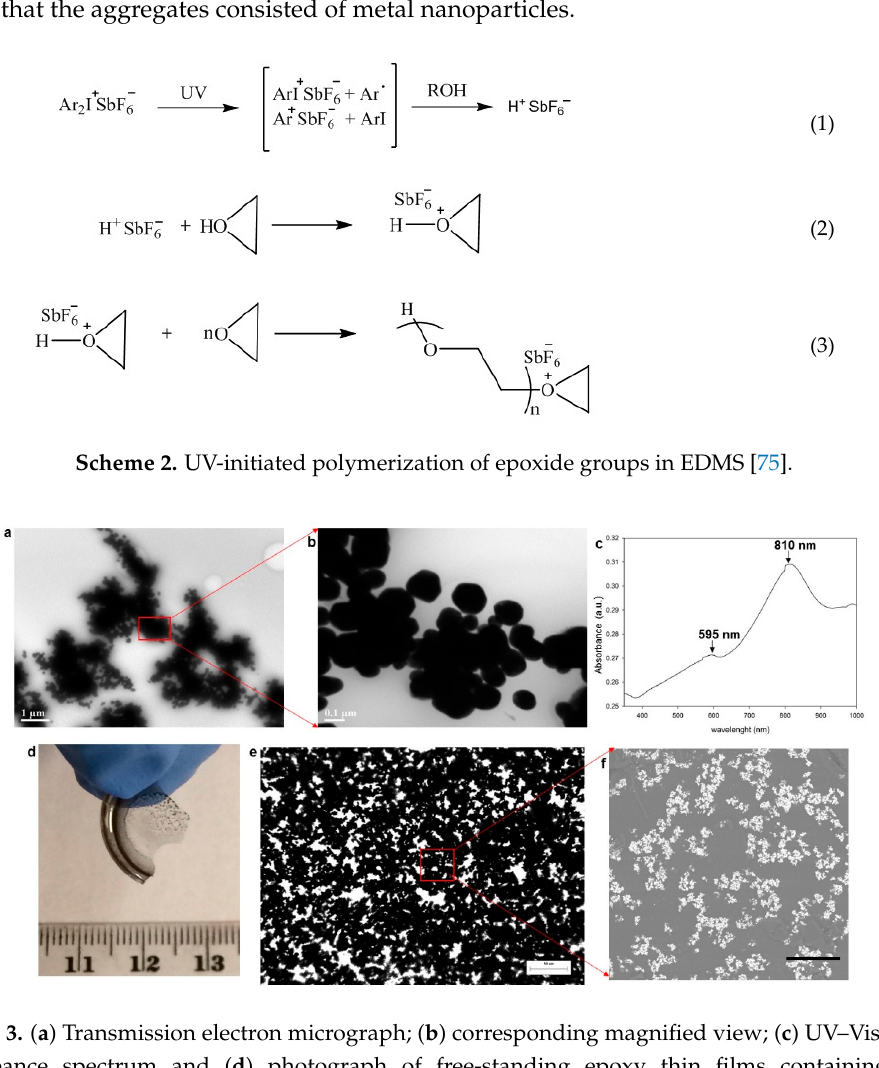
Figure 3. ( a ) Transmission electron micrograph; ( b ) corresponding magnified view; ( c )